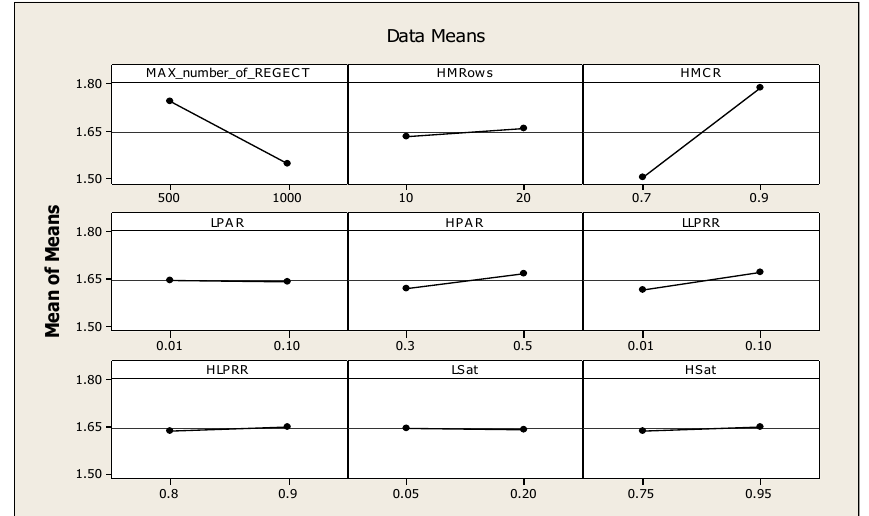
Figure 8. MHS main effects plot for the different factors.